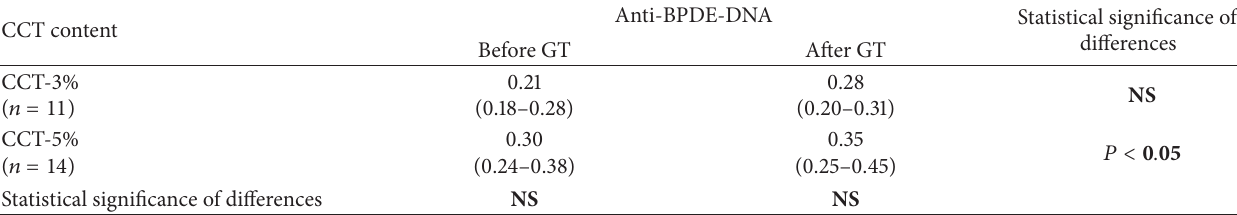
Table 3: The serum level of anti-BPDE-DNA before and after the therapy (smokers).